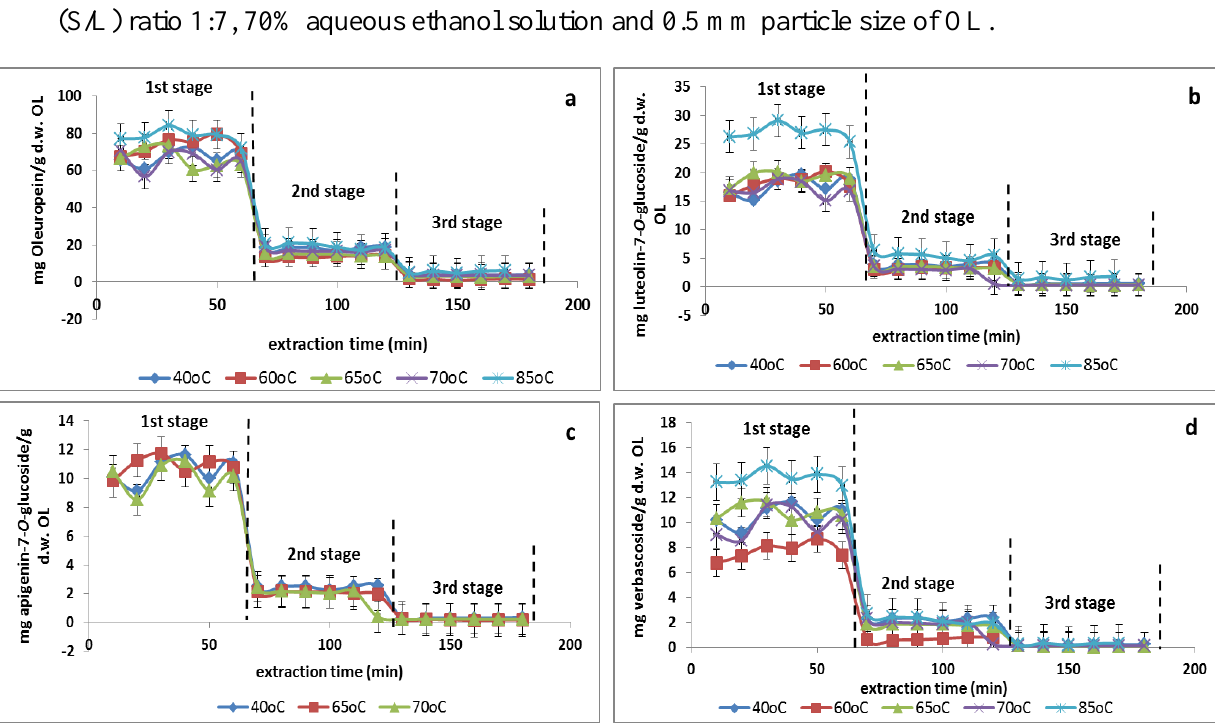
Figure 3. Mean values ( n = 3) of extraction yields (mg/g d.w. OL) of ( a ) oleuropein; ( b ) luteolin-7- O -glucoside; ( c ) apigenin-7- O -glucoside; and ( d ) verbascoside which are obtained after multistage extraction (60 min/stage) (sampling was performed every 10 min) at 40, 60, 65, 70 and 85 °C. The extraction was performed at pH 2.5 with